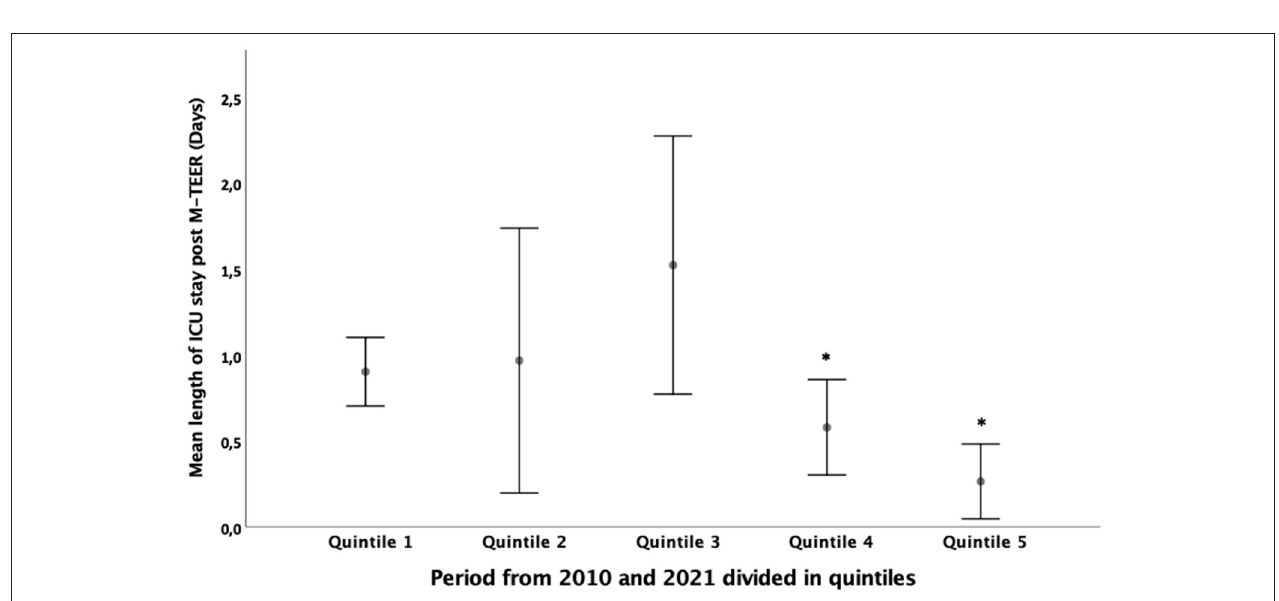
FIGURE 3 | Mean length of hospitalization in the ICU of patients with mitral regurgitation who underwent M-TEER from 2010 to 2021. * p < 0.05 for the difference between quintile 4 and 5 and other